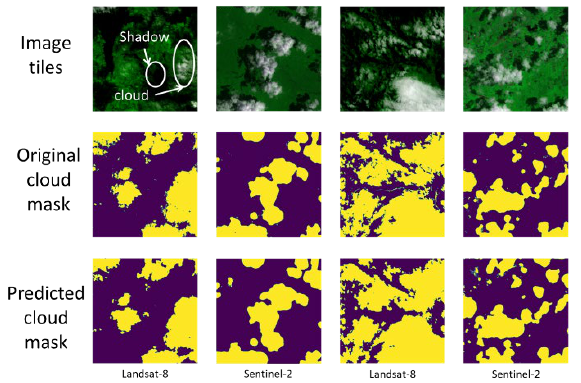
Figure 8. Samples of predicted cloud masks compared to original cloud masks.